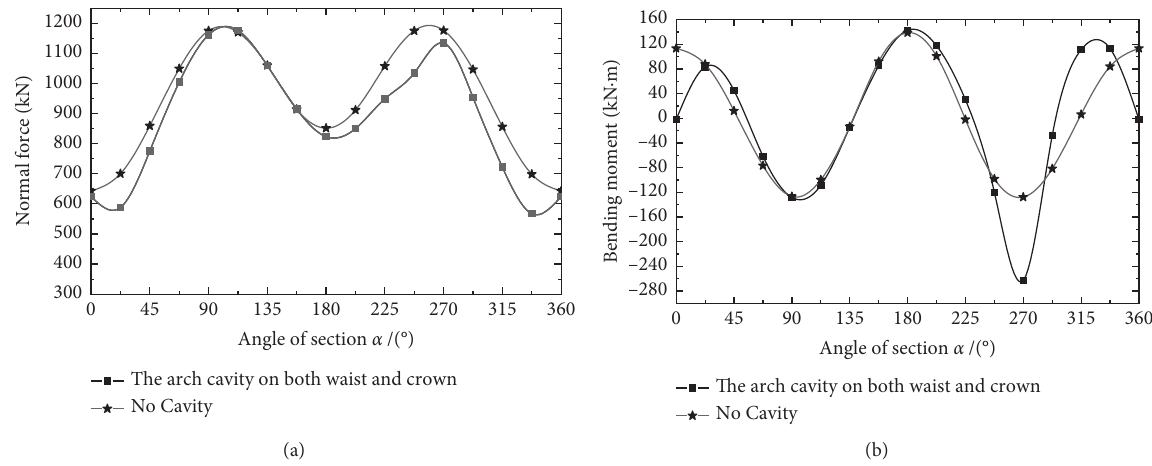
Figure 20: Internal force diagram of the cavity behind the vault and arch waist. (a) Segment axial force. (b) Segment bending